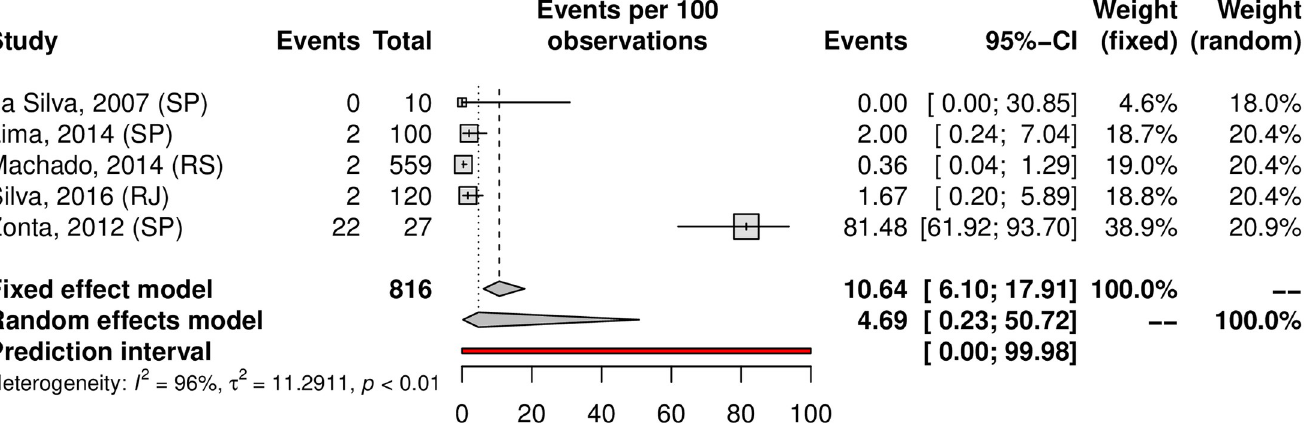
Fig 22. Overall prevalence of oral infection by high-risk HPV genotypes. Forest plot of a metanalysis of studies reporting prevalence of oral infection by HR-HPV in Brazil.